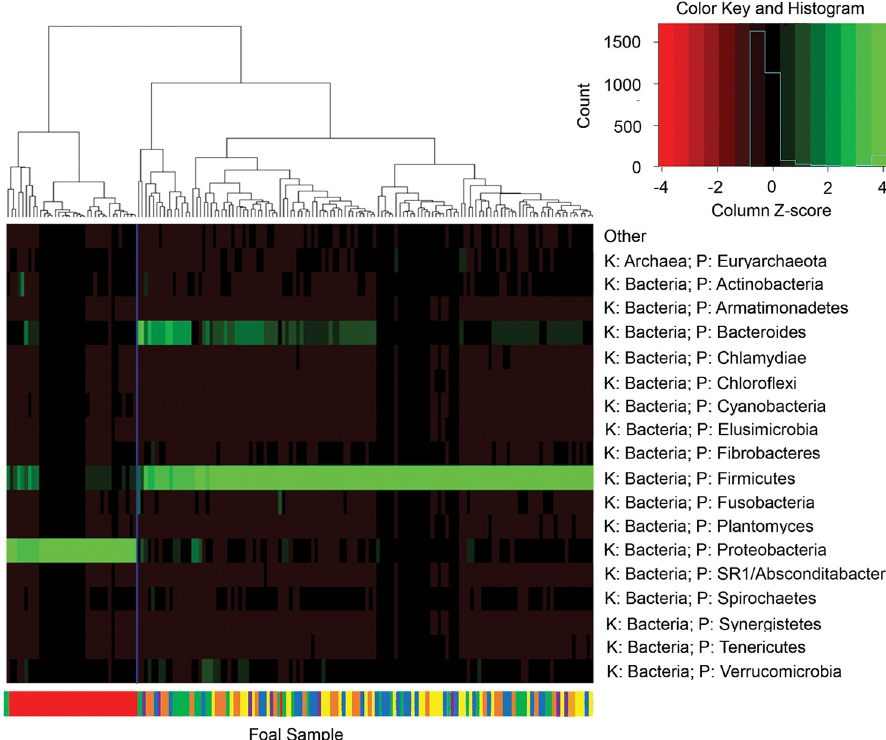
Fig 3. A dendritic plot and heatmap of the phyla present within each sample’s sequencing data demonstrate how individual fecal samples cluster together. From the sequence data, the most obvious finding in the heatmap is that Day 1 samples all have bacteria of the Phylum Proteobacteria in common, while samples outside of Day 1 all share bacteria from the Phylum Firmicutes . At the bottom of the heatmap is a color code of the samples in which the colors designated for each day are the same as Fig 2. In this heatmap, Day 1 foal samples cluster together; samples from other days cluster with each other.